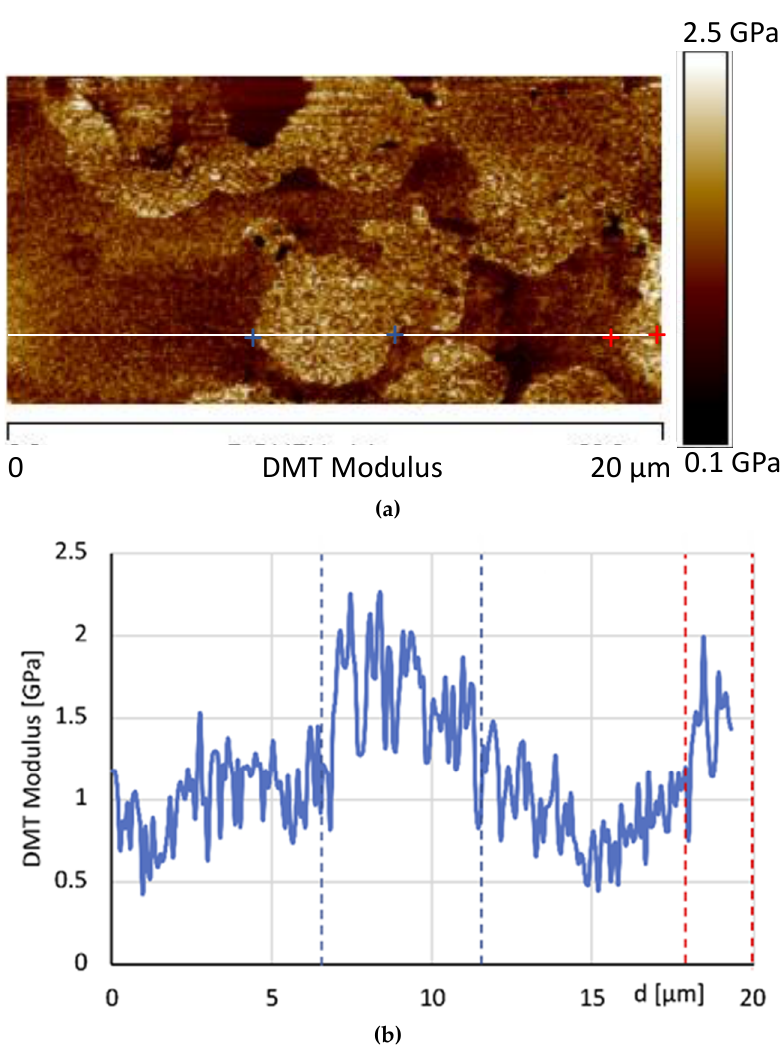
Figure 11. AFM image of the Derjaguin-Muller-Toporov (DMT) modulus maps of the sample 0GNPs ( a ) and AFM image of the DMT modulus maps of the sample 0GNPs with the profile of the value of the elastic modulus (elastic modulus scale of the sample taken along the white line) ( b ).